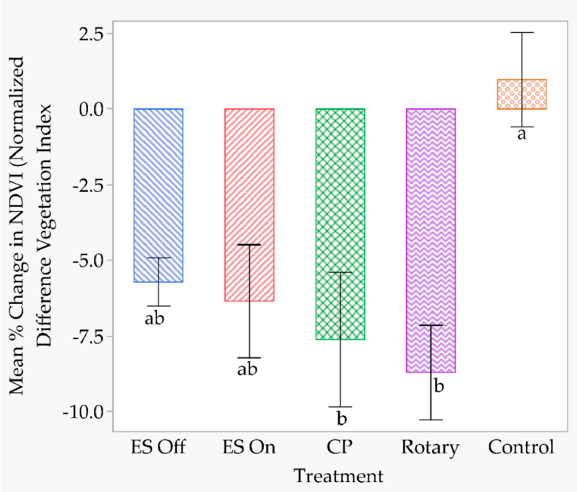
Figure 12. The percent change (±SEM) in NDVI values 16 DAT obtained from aerial imagery. Means followed by the same lowercase letter are not significantly different ( p < 0.05) according to Tukey’s HSD test. The treatments described on the X -axis are electrostatically charged off (ES Off) and charged on (ES On) nozzles, the conventional hydraulic (CP) nozzle, and the rotary atomizer (Rotary) nozzle, compared with the Control.